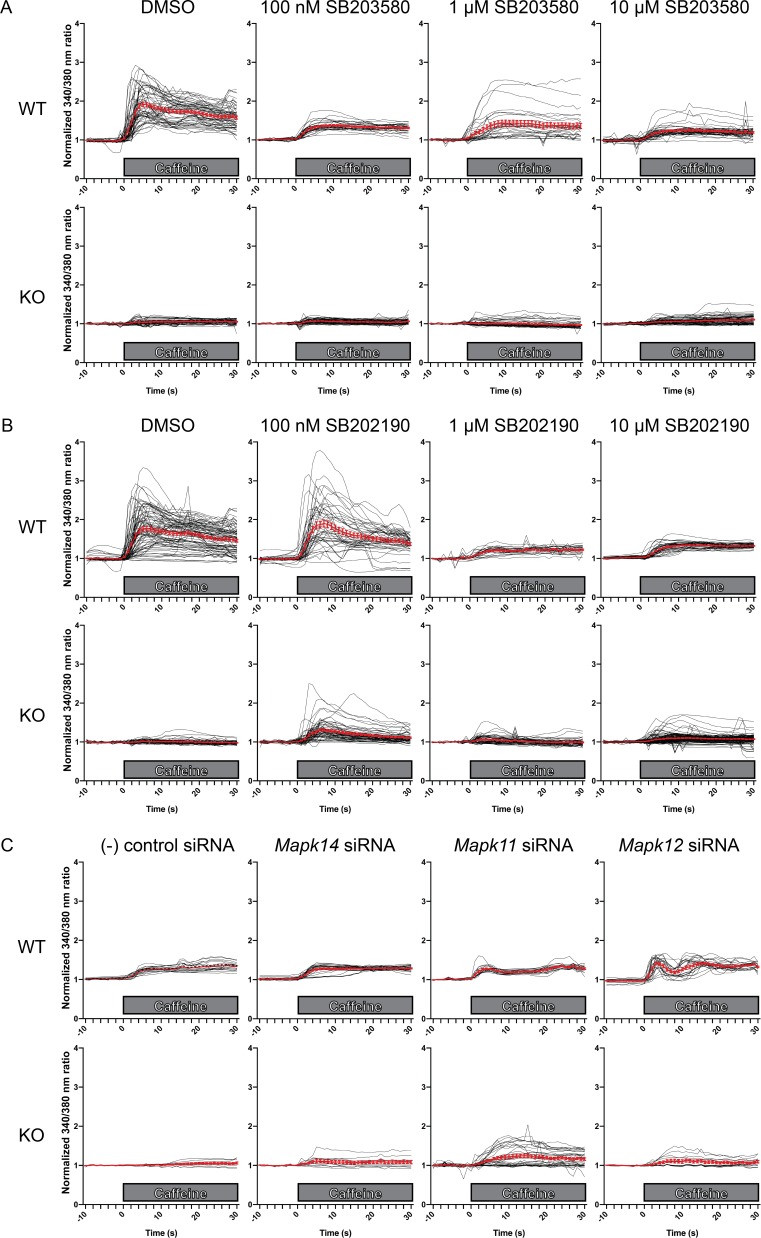
Intracellular calcium measurement in C2C12 myotubes.Ratiometric fura-2 imaging with 10 mM caffeine induction after treatment with A) SB203580, (B) SB202190, and C) p38 MAPK siRNAs. Black lines indicate individual myofibers while red lines present the mean ± SEM as show in Figure 5. Ratiometric 340/380 data were normalized to the average of 10 s of baseline resting free Ca2+ concentration ([Ca2+]i), that is normalized Δ ratio.